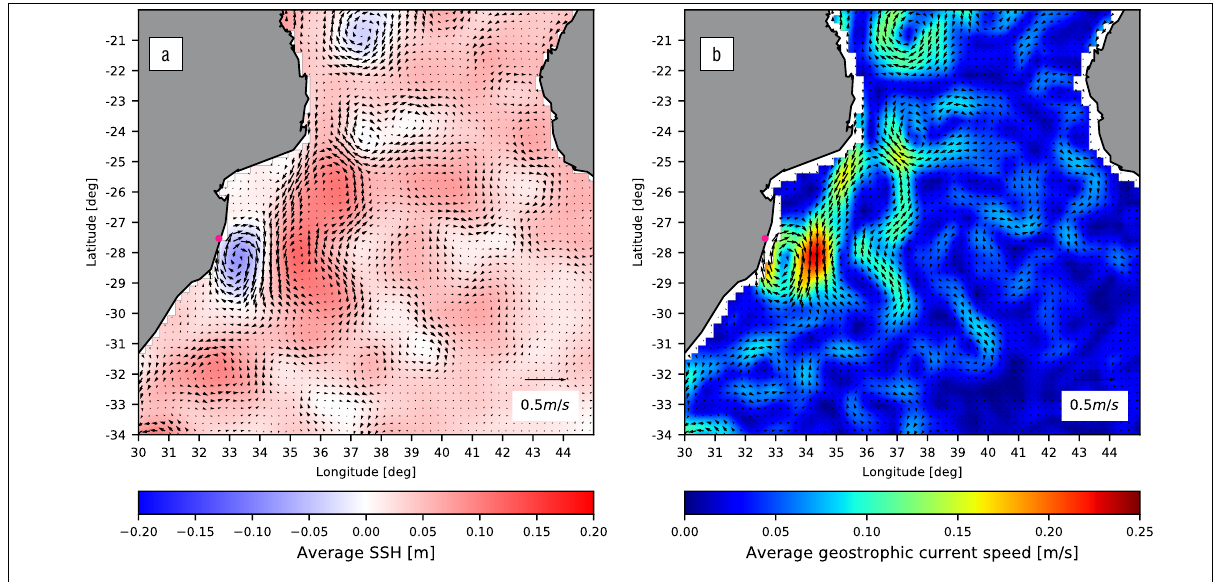
Figure 5: (a) Conditionally averaged sea surface height (SSH) field at the peak of the temperature anomalies using a -2 °C threshold. (b) Conditionally averaged geostrophic current field at the peak of the temperature anomalies using a -2 °C threshold. Geostrophic currents have been overlaid as a quiver plot and are scaled by speed.